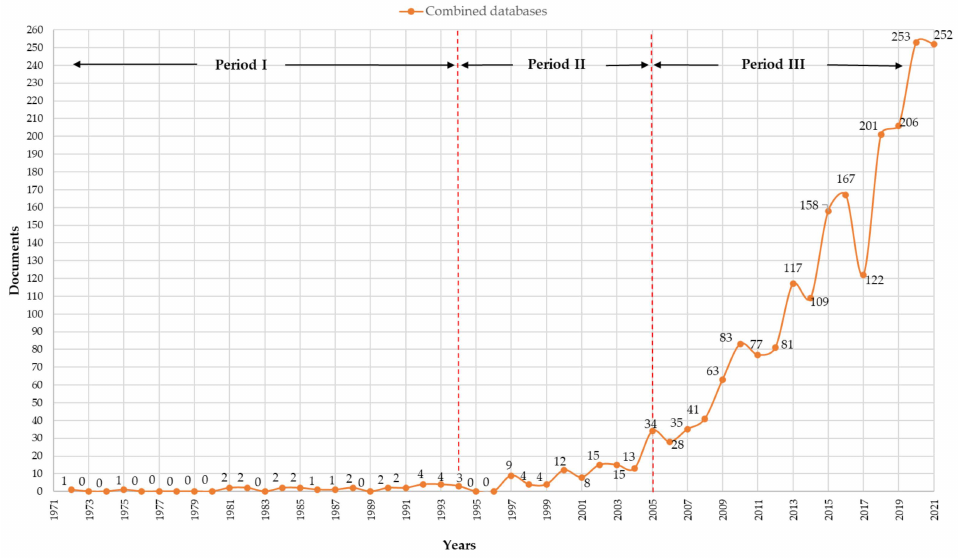
Figure 4. The annual production of the study field from flood